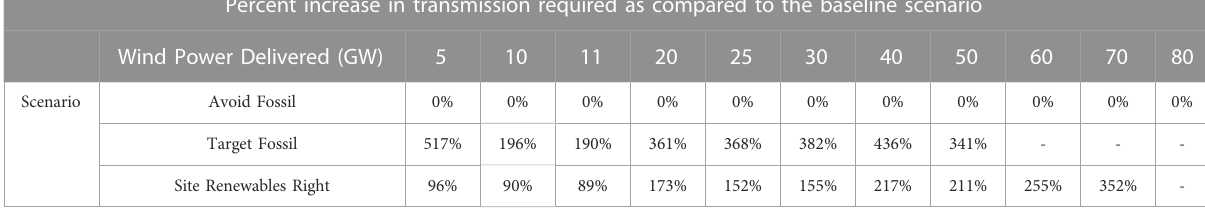
TABLE 5 Change in transmission requirements using the baseline scenario as a reference. Percent increase in transmission required as compared to the baseline scenario Wind Power Delivered (GW)